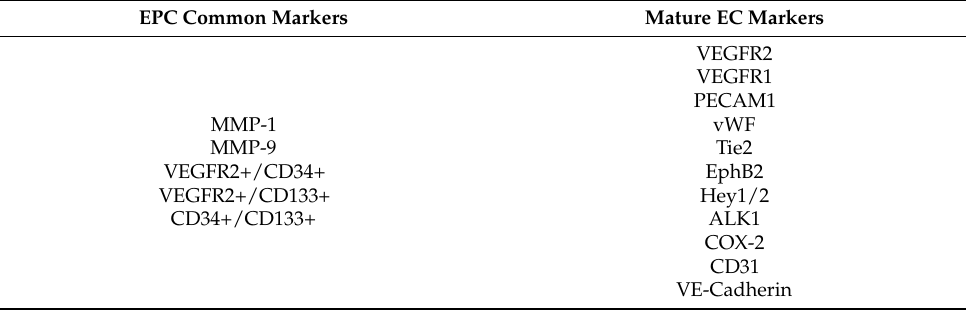
Table 2. Different markers for EPC and mature ECs on